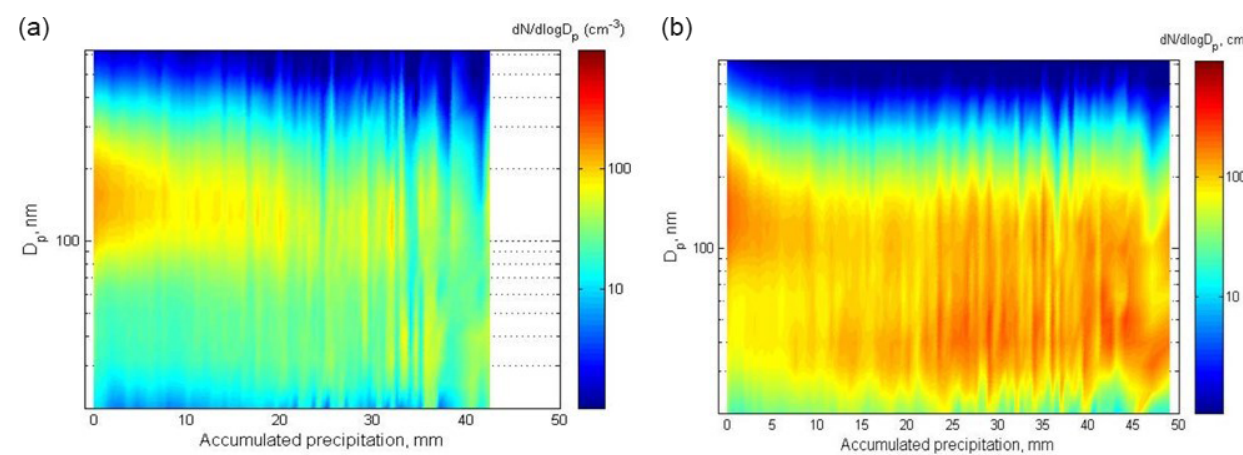
Figure 10. Evolution of aerosol number size distribution (d N/ dlog D p ) as a function of accumulated precipitation along 240h trajectories (a) for the dark period (October to February) and (b) for the sunlit period (March to September). All data from 2000 to 2010 (Tunved et al.,